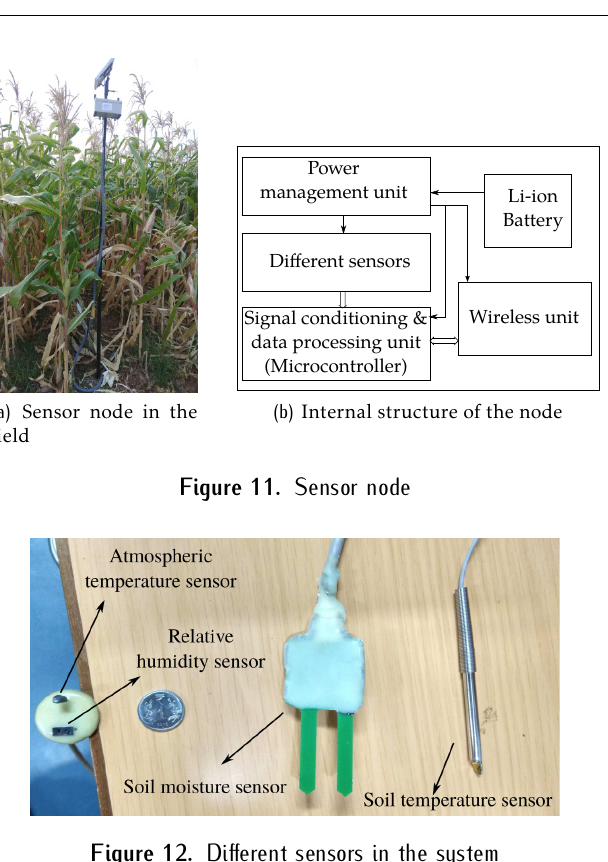
Figure 12. Different sensors in the system